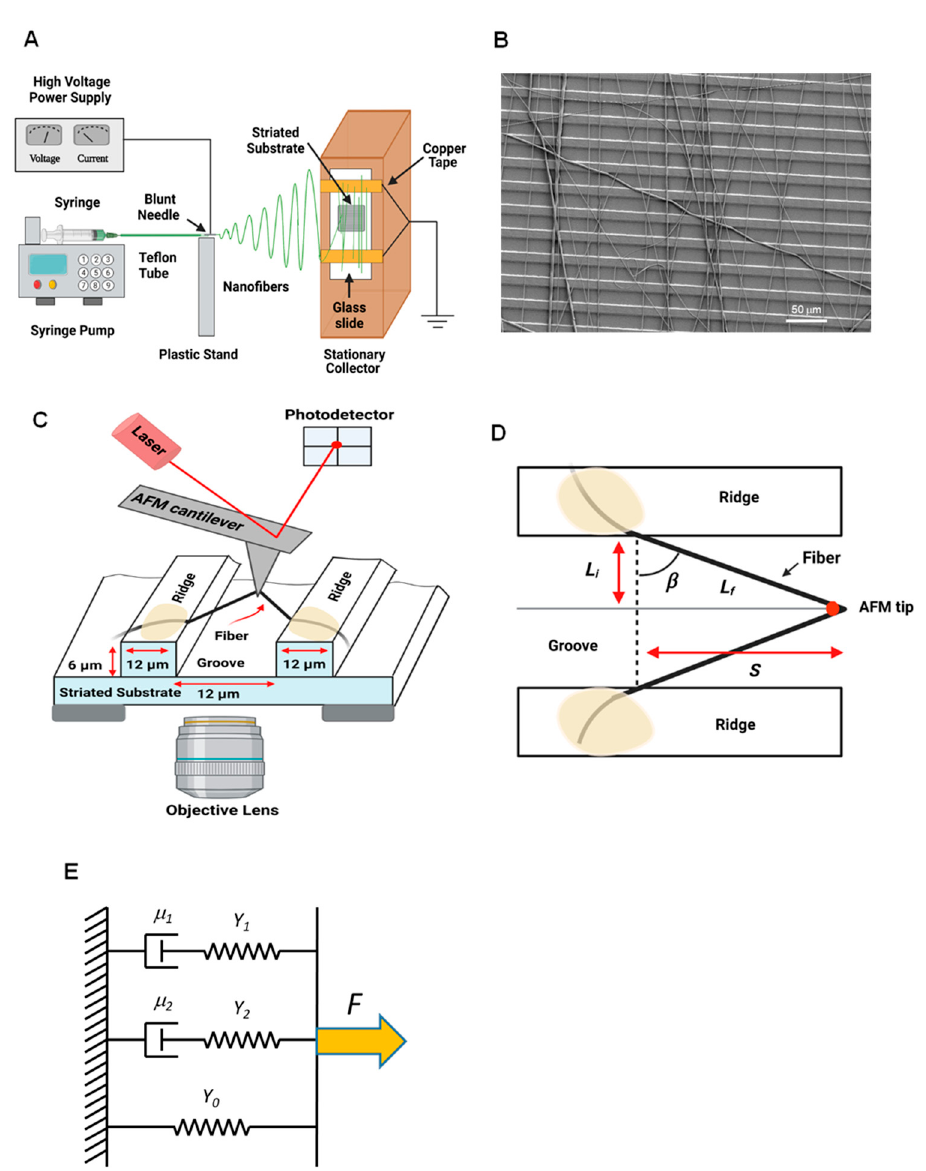
Figure 1. ( A ) Schematic diagram of set up of electrospinning apparatus. ( B ) SEM image of partially aligned, electrospun fibrinogen:PCL fibers on striated substrate. The gap between two ridges is 12 µm. ( C ) Schematic diagram of the AFM manipulating a nanofiber. ( D ) Top view of a pulled fiber. ( E ) Kelvin model of three mechanical elements in parallel. Figure adapted from [56]. Parts of Figure 1 were created with BioRender.com.